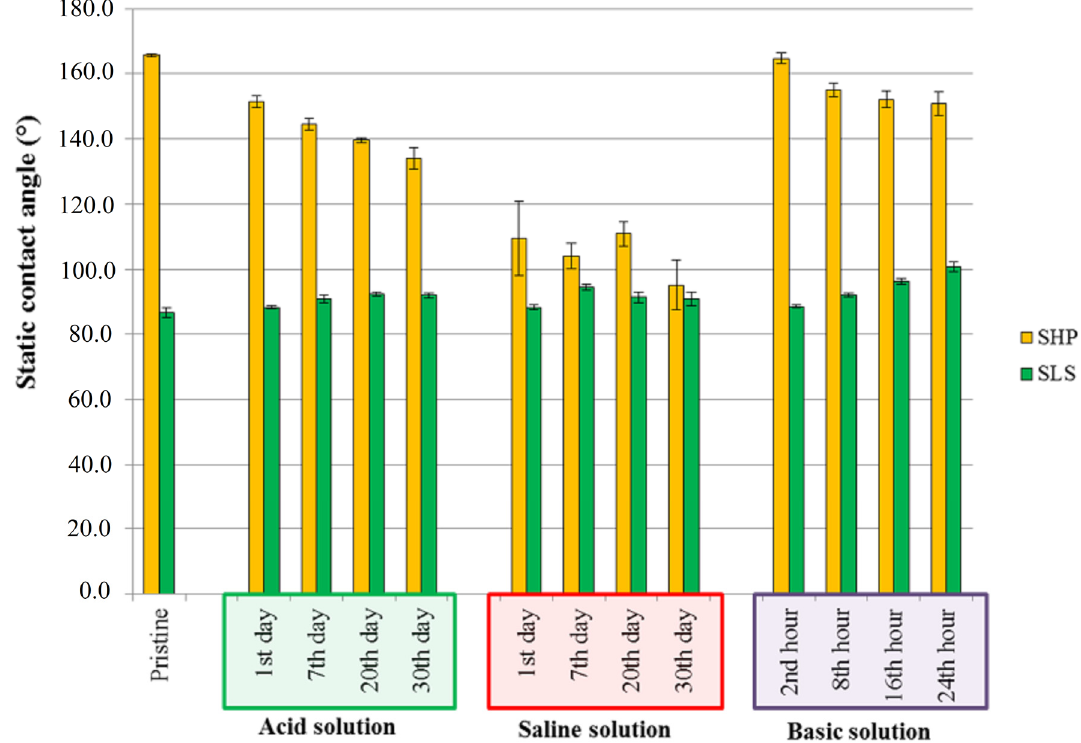
Figure 6. Static contact angles of SHP and SLS after aging in acid, saline and basic solutions.